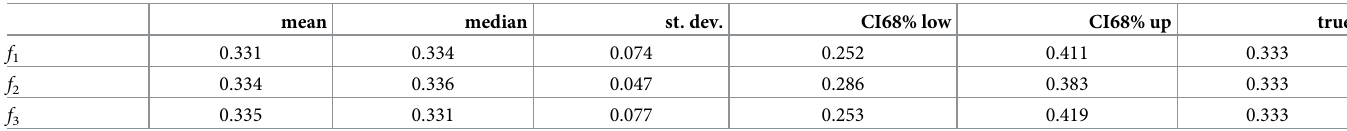
Table 4. Results of the MCMC calculations for the mixing of the three sources. The sources were separated very well and contributed equally to the sample mixture. mean median st.